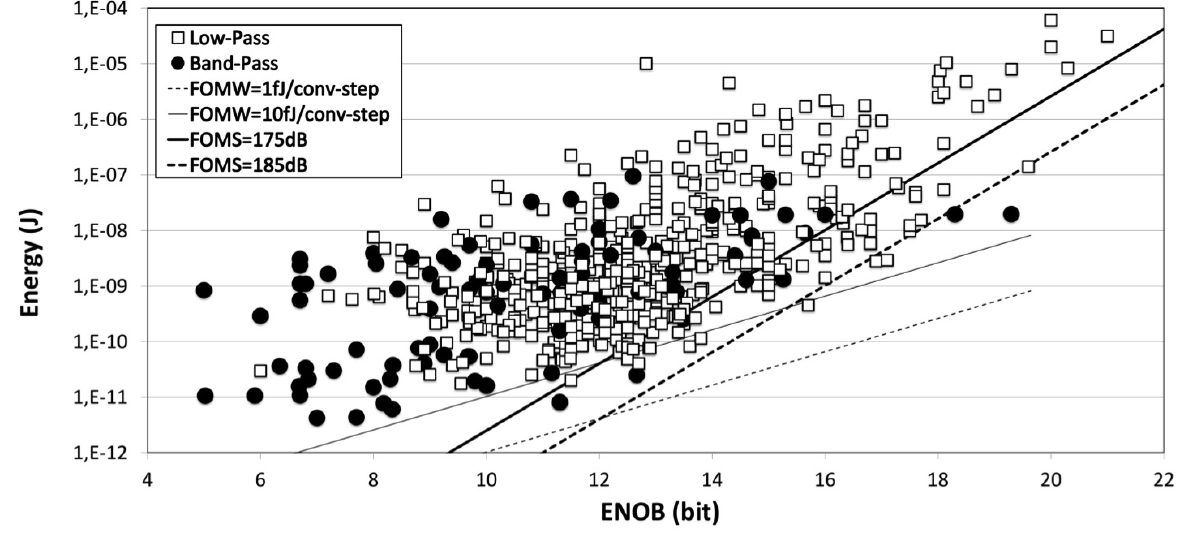
Figure 14. Energy plot of Σ∆ Ms using Equation (25) to compute the conversion energy of BP- Σ∆